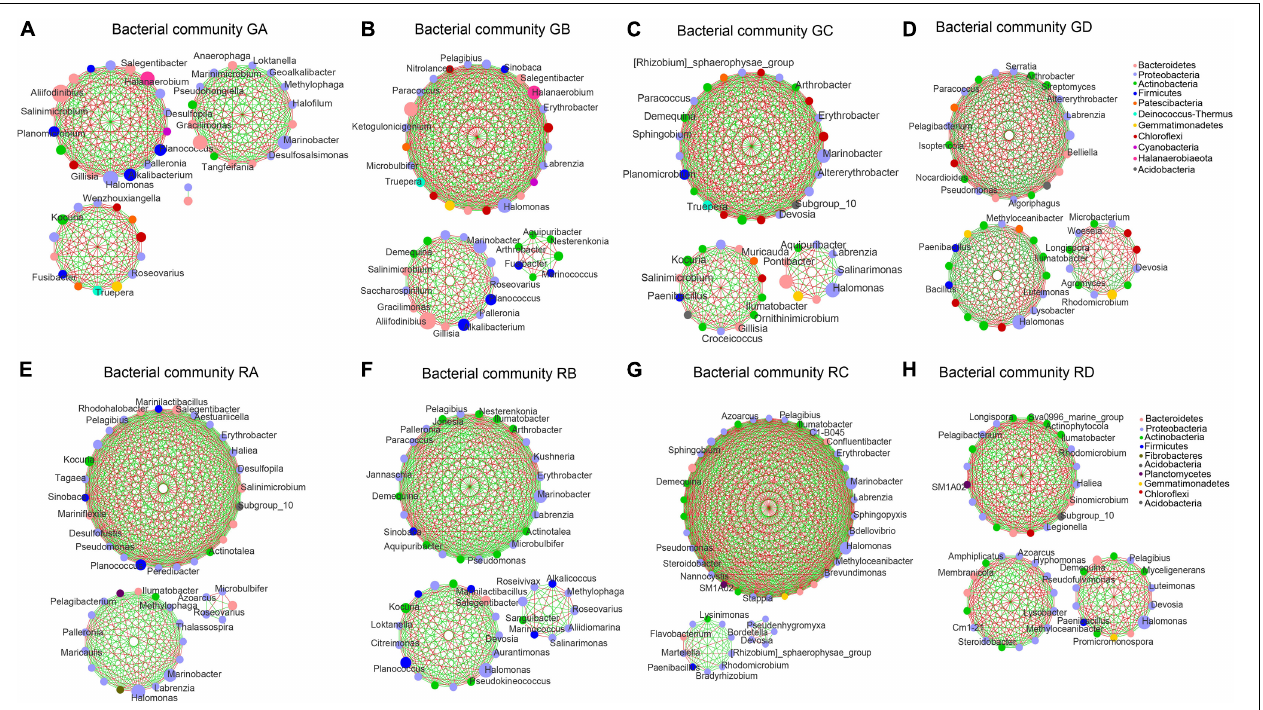
FIGURE 5 | An overview of the bacterial network interactions in Ejinur Salt Lake different rhizosphere soil and root endophytic samples. The connections in the network represent a strong (| r | > 0.6) and significant ( p < 0.01) correlation. Colors of nodes represent different major phyla; the node representing genus is written inside. A green link indicates a negative interaction, whereas a red link implies a positive interaction between two individual nodes. Uppercase “G” represents the rhizospheric sample, and lowercase “R” represents the endophytic samples. (A–D) S. europaea rhizosphere soil (GA), S. salsa rhizosphere soil (GB), P. communis rhizosphere soil (GC) and A. splendens rhizosphere soil (GD). (E–H) Salicornia europaea endophytic samples (RA), Suaeda salsa endophytic samples (RB), Phragmites communis endophytic samples (RC) and Achnatherum splendens endophytic samples